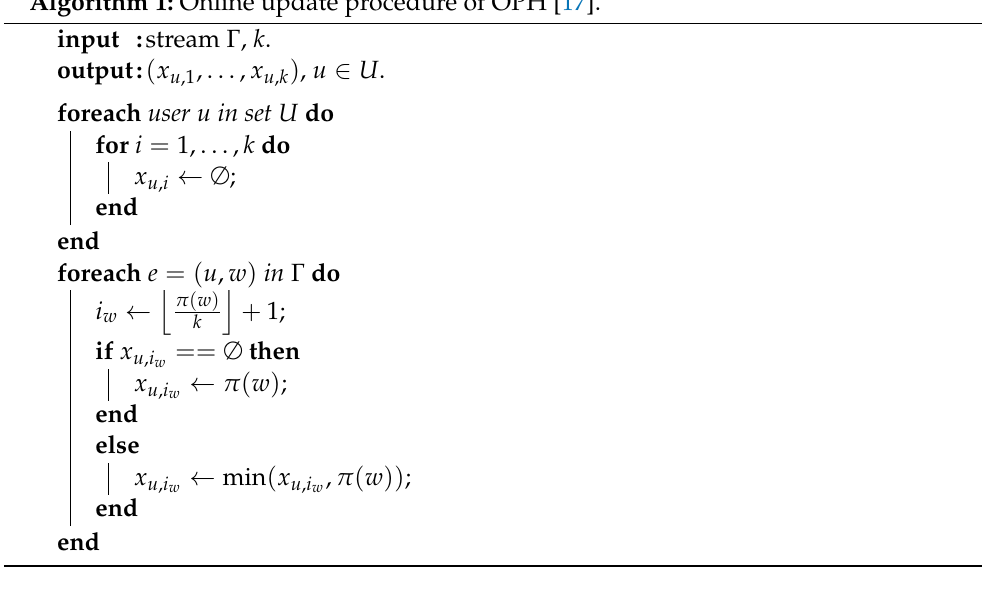
Algorithm 1: Online update procedure of OPH